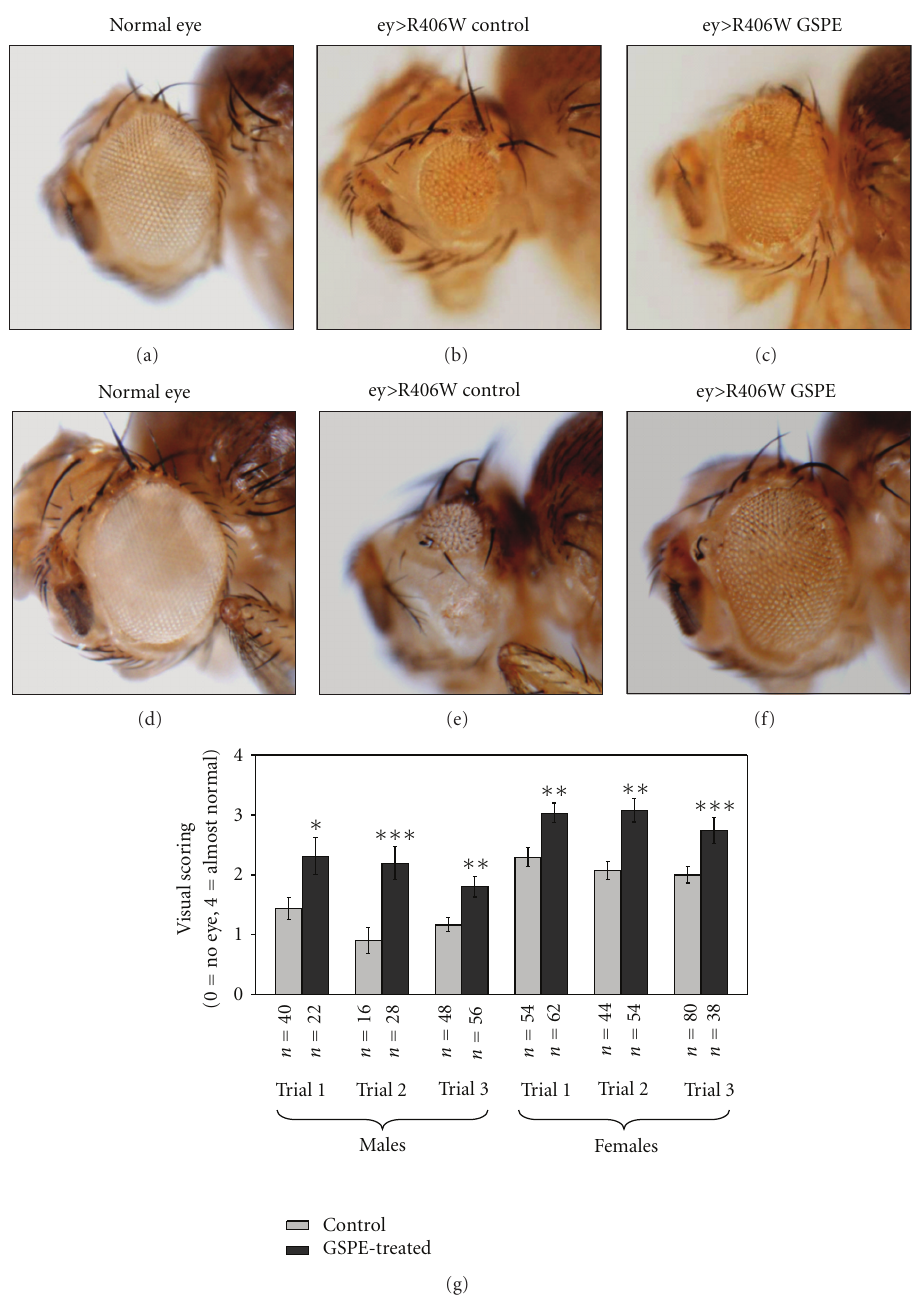
Figure 1: GSPE attenuates R406W tau overexpression in the fly eye . Male and female eye size di ff ers; male eyes are shown in (a)–(c), and female eyes are shown in (d)–(f). Overexpression of R406W early in eye development results in a small or no eye ((b), (e)). Eyes that do not overexpress R406W are shown in (a), (d) for comparison. GSPE treatment ameliorates the reduction in eye size (representative eyes shown in (c), (f)). GSPE treatment does not a ff ect normal-eye development (not shown). (g) The range of ey > R406W phenotypes varies between trials, so treatment comparisons were made within experiments. The average visual score (0 = no eye, 4 = almost normal eye) ± SEM of male and female eyes is shown for three independent trials for males and three independent trials for females. The number of flies ( n ) and P value calculated using a paired t -test on GraphPad online software are indicated beneath each trial. Flies were collected within 5 days of eclosion. Statistically significant improvement ( P < . 05) was observed in multiple independent experiments. ∗ indicates P < . 05, ∗∗ indicates P < . 01, and ∗∗∗ indicates P < . 001. (An excerpt of these images has been presented without data in a review manuscript by the